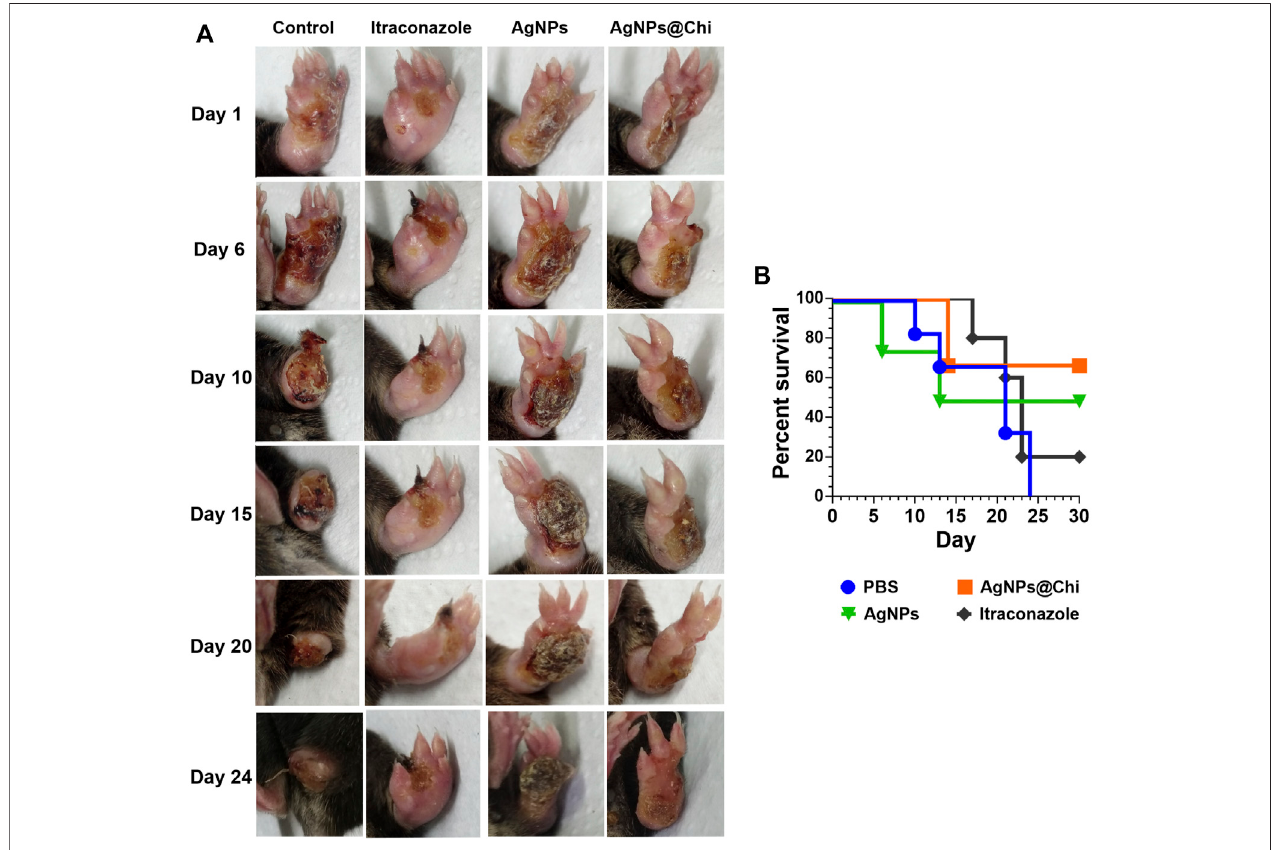
FIGURE 6 | Protective effect of nanoparticles in a murine model of severe sporotrichosis. (A) Mice subcutaneously infected with S. brasiliensis were treated with silver nanocomposites and itraconazole. For AgNPs and AgNPs@Chi, the treatment was carried out by spray (three applications from a 5 μ g/ml silver suspension). Itraconazolewasadministeredintravenously (0.5 mg/kg/day/per tail) asacontrol treatment. (B) Survivalofmice infected with S. brasiliensis . Dailytreatmentwasstarted 15 days after infection, when the injuries were evident. Once the last mouse in the control group died, mice survivors from other groups were treated for a further 6